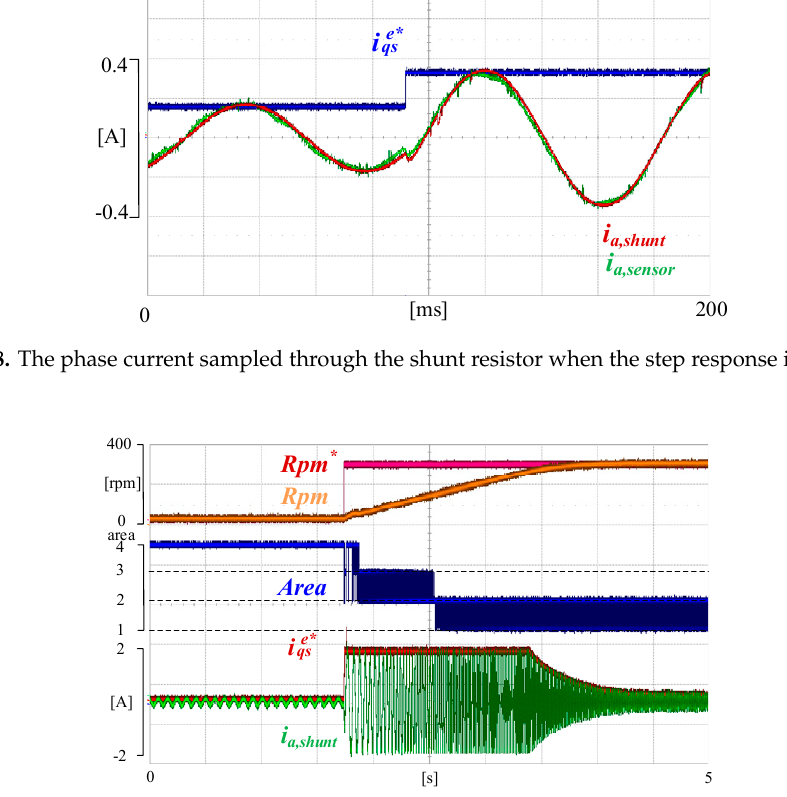
Figure 19. The transient response of speed control through all operation regions.